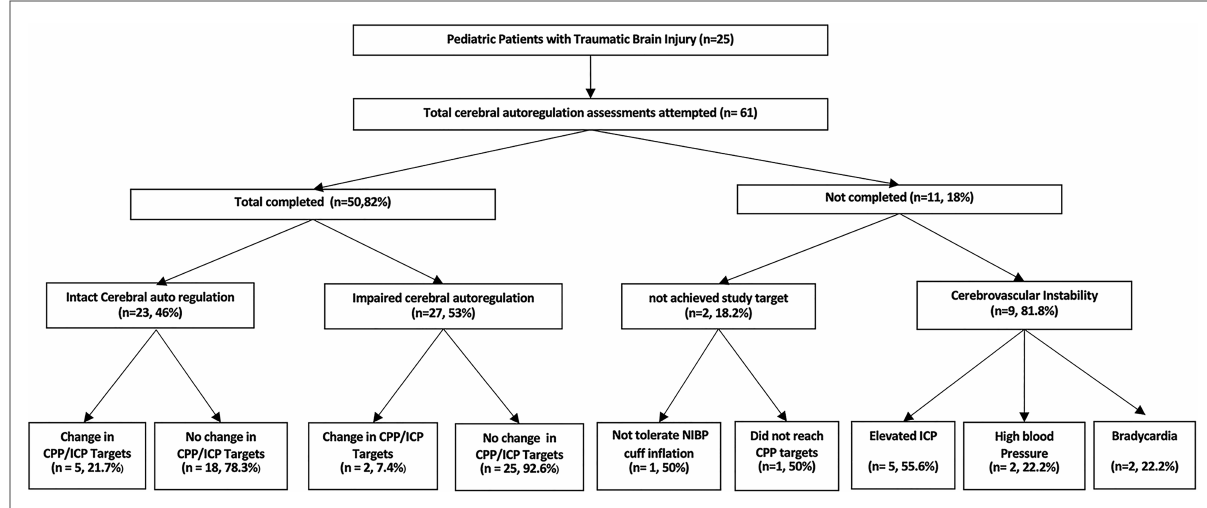
FIGURE 1 Performance of cerebral autoregulation assessments in hospitalized children with traumatic brain injury. ICP, intracranial pressure; CPP, cerebral perfusion